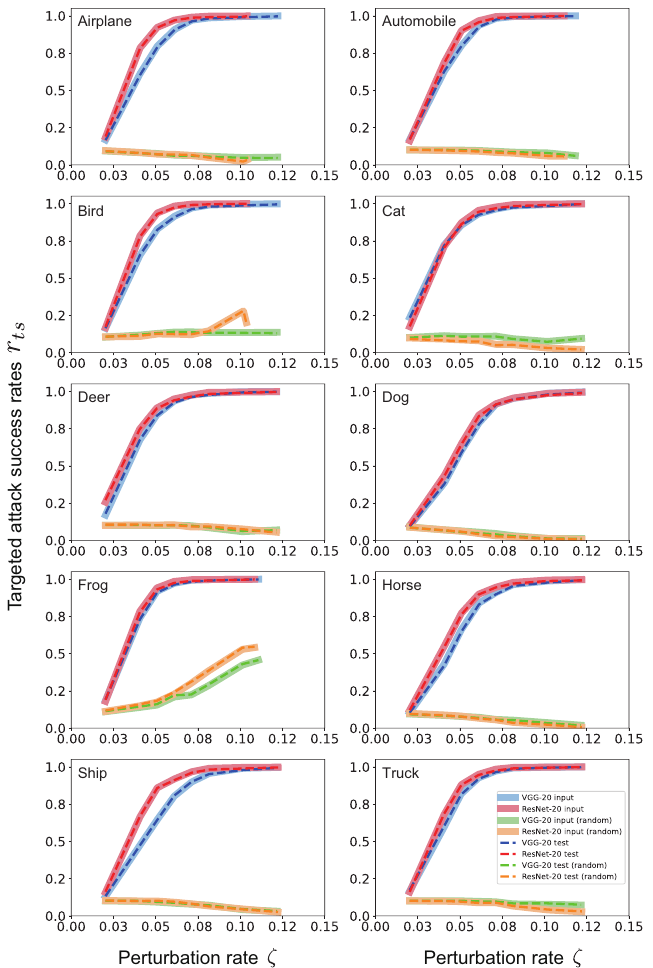
Figure 1. Line plot of the target attack success rate r ts versus the perturbation rate for targeted attacks for each class of the CIFAR-10 dataset. The legend label indicates the DNN model and image set used for computing r ts . For example, “VGG-20 input” indicates the r ts of targeted UAPs against the VGG-20 model computed using the input image set. The additional argument “(random)” indicates that random UAPs were used instead of targeted